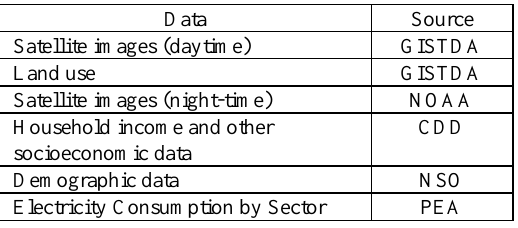
Table 1: Source of Statistical and Geographical data